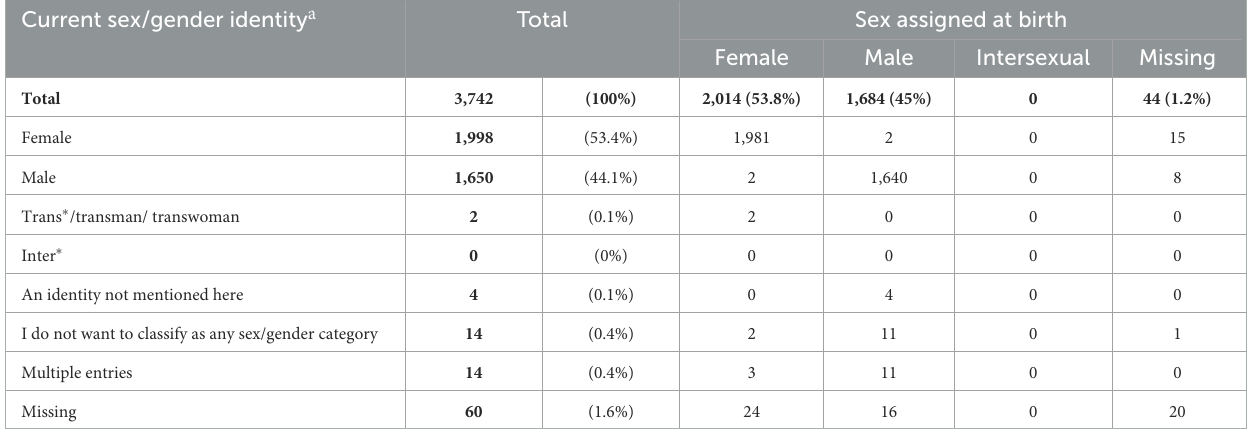
TABLE 3 Frequency distribution of sex assigned at birth and the current sex/gender identity. Current sex/gender identity